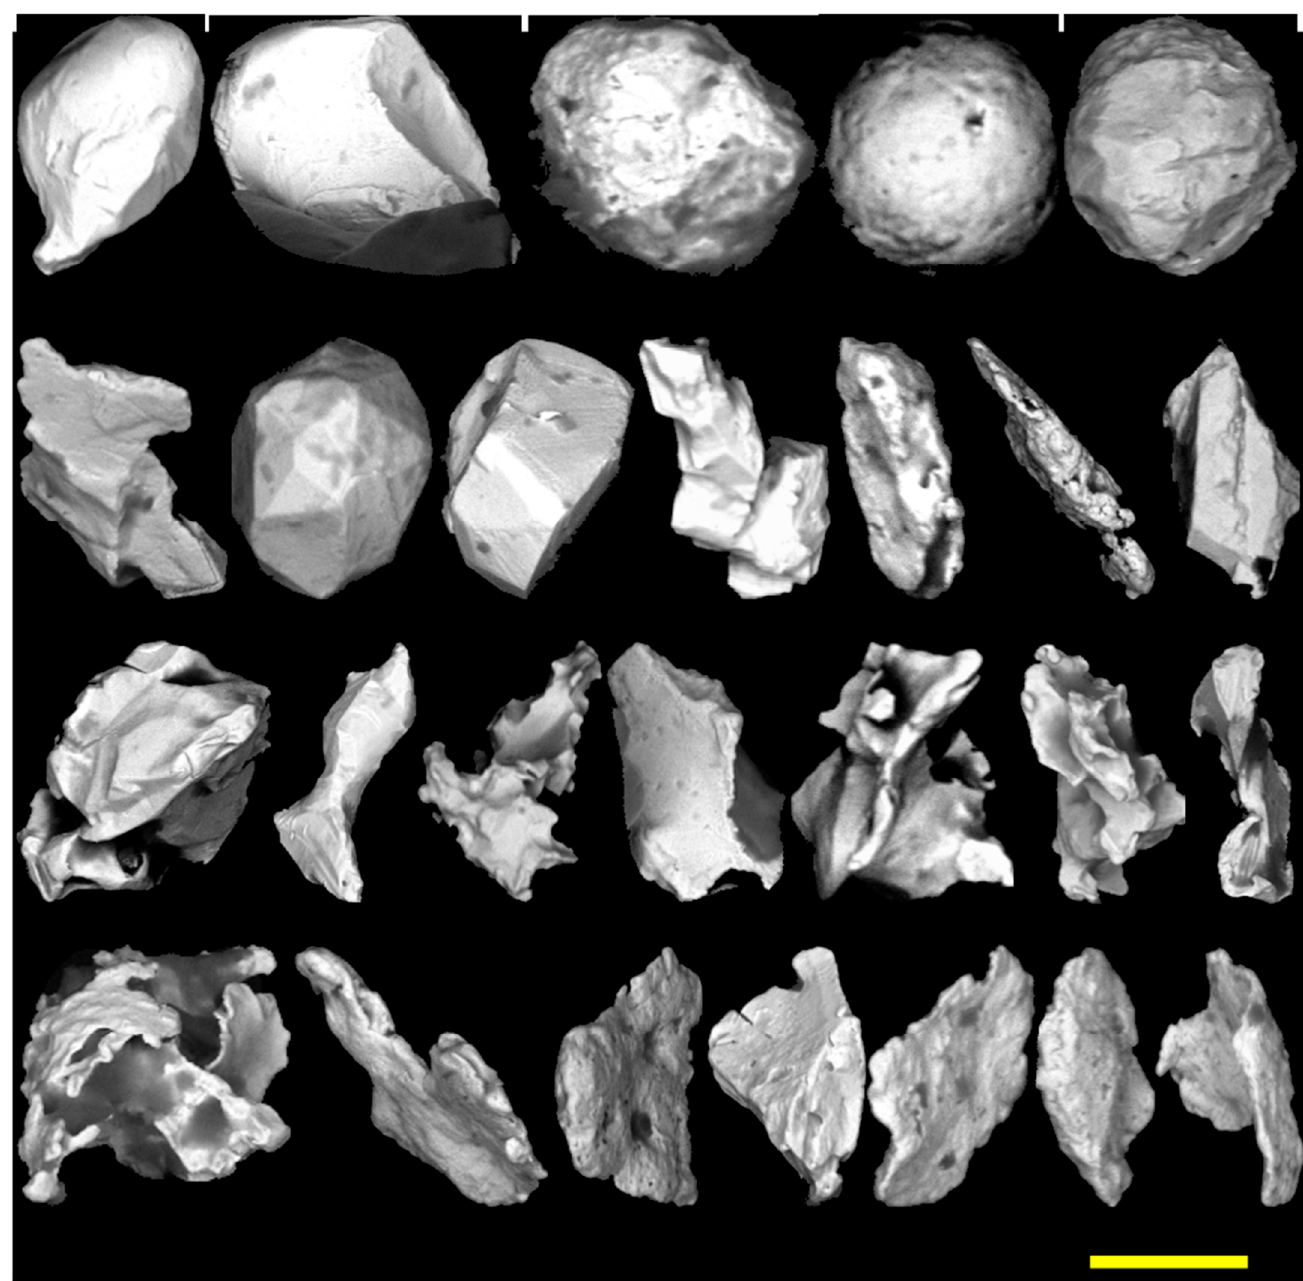
Figure 9. Mosaics of BSE images of grains classified as “mutual” (upper row), “crystalline,” “intergranular” and “remobilized” (lower row). All images are BSE with a resolution 0.14 µm. Grains size range between 20 µm to 30 in µm length. Grains were selected from different samples and projects. Morphologies were classified with the used of ARTMorph automated CNN routine. Scale bar is approximately 20 µ m in length.